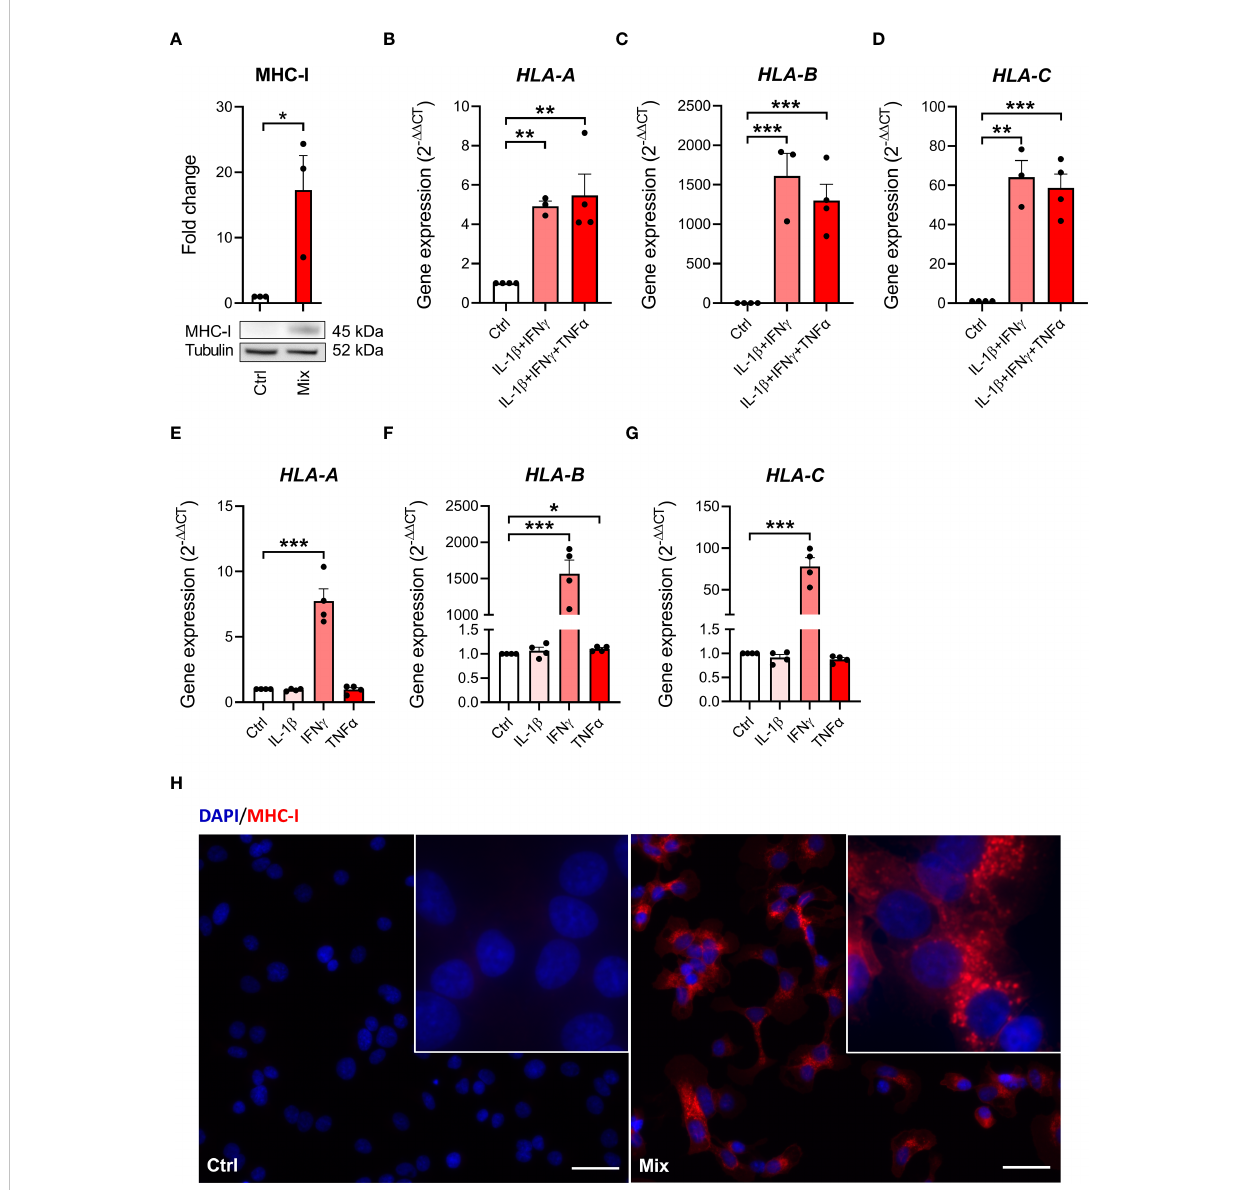
FIGURE 3 Cytokine-induced upregulation of MHC-I in EndoC- b H5 cells. (A) Immunoblotting of MHC-I in cells exposed to cytokines (50 U/mL IL-1 b , 1000 U/ mL IFN g and 1000 U/mL TNF a ) (Mix) for 96 h. Tubulin was used as a loading control. Data are means ± SEM (n=3). Gene expression of (B) HLA-A (C) HLA-B and (D) HLA-C in cells exposed to two or three cytokines for 48 h, and gene expression of (E) HLA-A (F) HLA-B and (G) HLA-C in cells exposed to individual cytokines for 48 h. GAPDH was used as housekeeping gene. Data are means ± SEM (n=3-4). (H) Immuno fl uorescence staining of MHC-I (red) and DAPI nuclei staining (blue) in EndoC- b H5 cells after 48 h of cytokine exposure. Scale bars indicate 50 m m (20x); zoom (60x). Representative images are shown. *p<0.05, **p<0.01, ***p<0.001. Ctrl, untreated